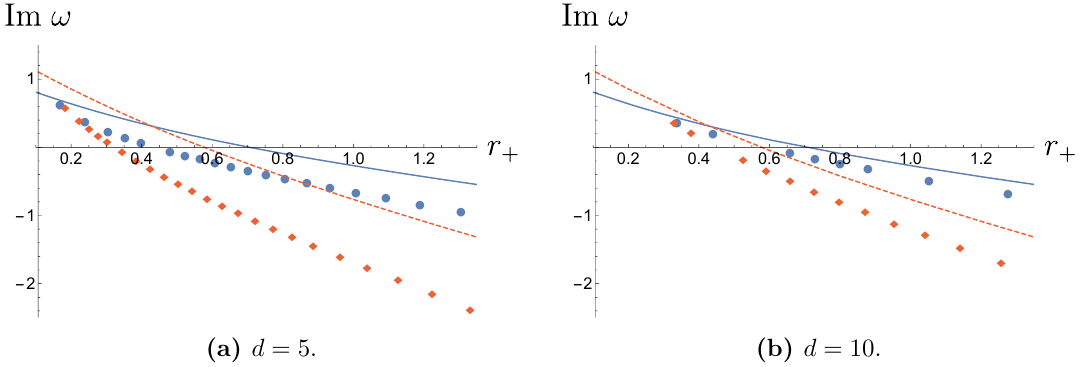
Figure 2 . Threshold radius of dynamical instability for d = 5 ; 10. The dashed lines are the large n = d (cid:0) 3 approximation (2.19) including the terms up to n (cid:0) 1 and n (cid:0) 2 order, serving as the lower and upper bounds respectively. The dots are the numerical results; the solid line is the n ! 1 limit.